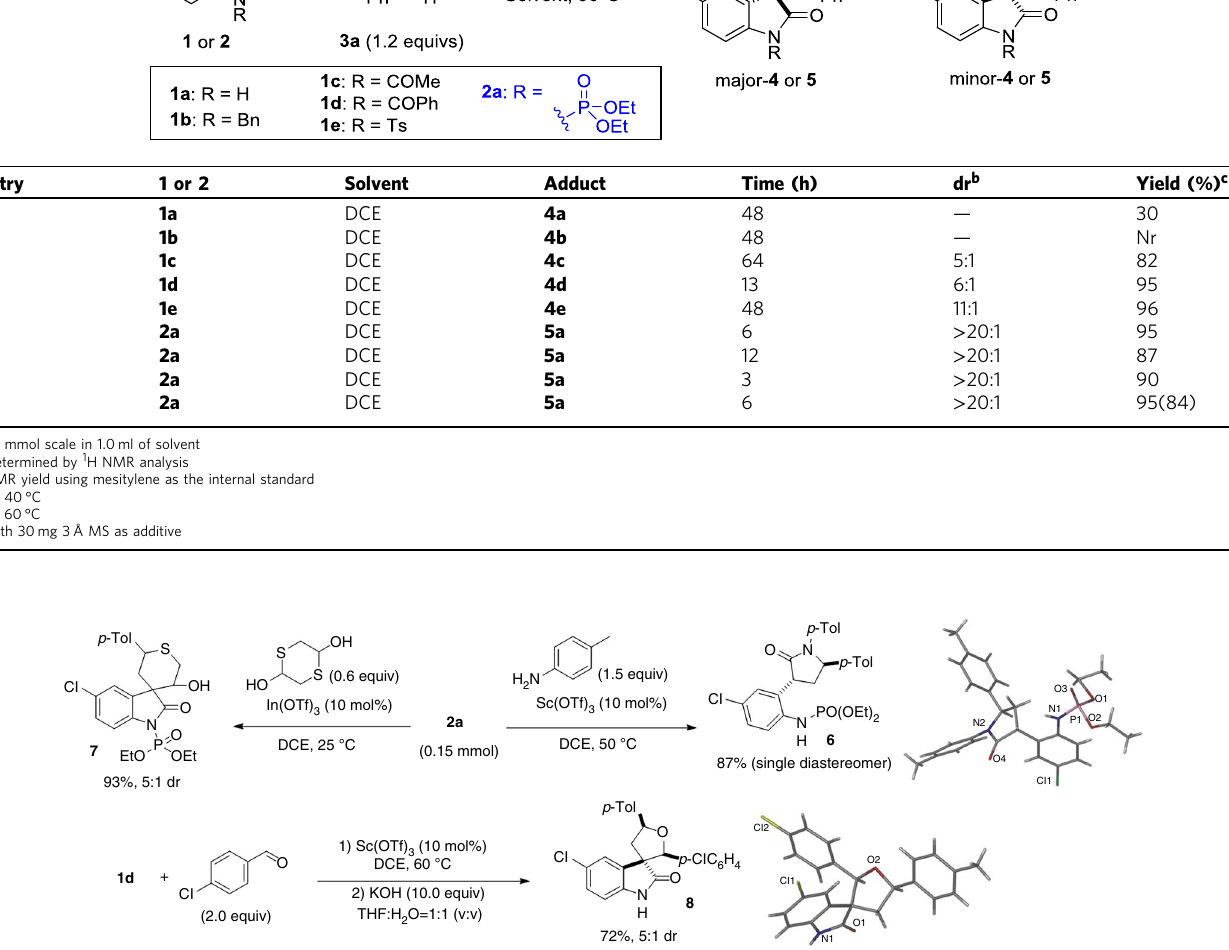
Fig. 2 Other typical reactions of the activated spirocyclopropyl oxindoles. Ring opening reaction of 2a using p -toluidine. Cyclization reaction of 2a with 1,4-dithiane-2,5-diol. Diploar cycloaddition of 1d with 4-chlorobenzaldehyde, followed by deprotection using KOH.